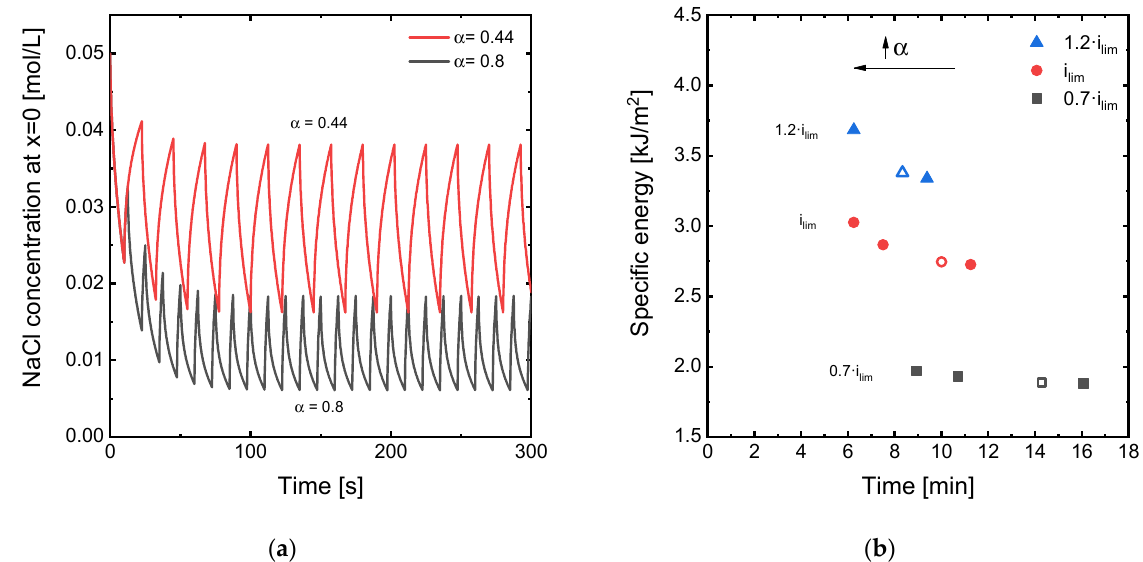
Figure 8. ( a ) Evolution with time of the NaCl concentration at the interface between the membrane surface and the diluting DBL (position x = 0) under the application of i lim in PEF mode with different duty cycles: 10 s–12.5 s ( α = 0.44) and 10 s–2.5 s ( α = 0.8); ( b ) trade-off between the specific energy consumption and the time needed to achieve a charge transport of 16,800 A·s at different levels of current density with t on = 10 s and varying duty cycles. Empty symbols represent the conditions for α = 0.5, where t on = t off = 10 s.